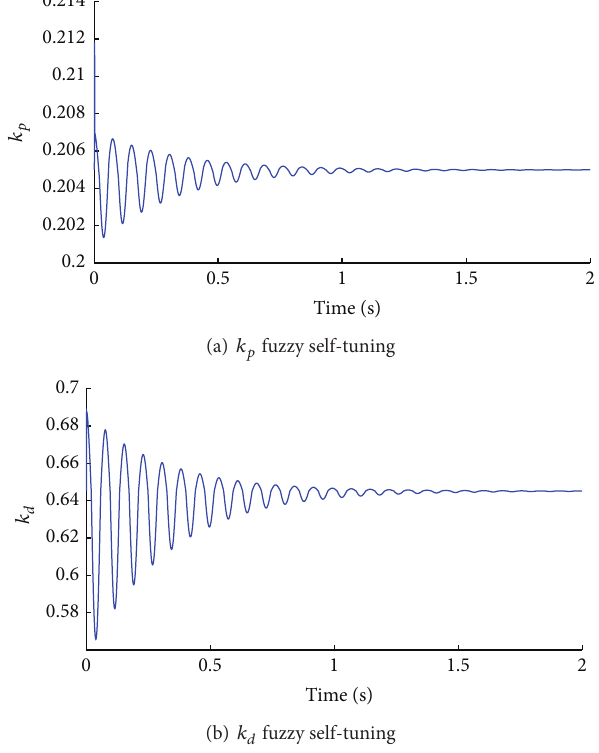
Figure 7: Fuzzy self-tuning of controller parameters in initial displacement